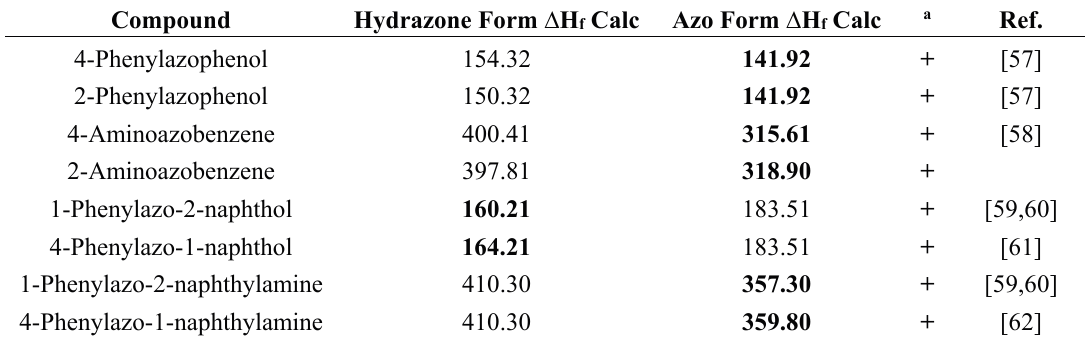
Table 6. Thermodynamic Data (kJ/mol) of Azo